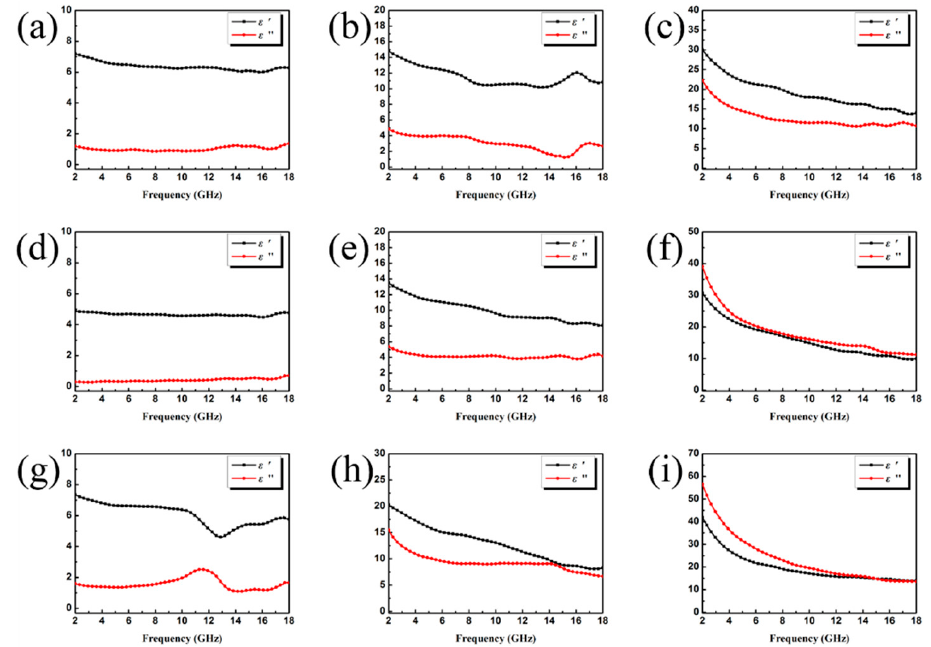
Figure 7. Frequency dependence of the real and imaginary parts of complex permittivity of sample A with a filler loading of ( a ) 20 wt%, ( b ) 30 wt%, ( c ) 40 wt%; sample B with a filler loading of ( d ) 20 wt%, ( e ) 30 wt%, ( f ) 40 wt%; sample C with a filler loading of ( g ) 20 wt%, ( h ) 30 wt%, ( i ) 40 wt%.